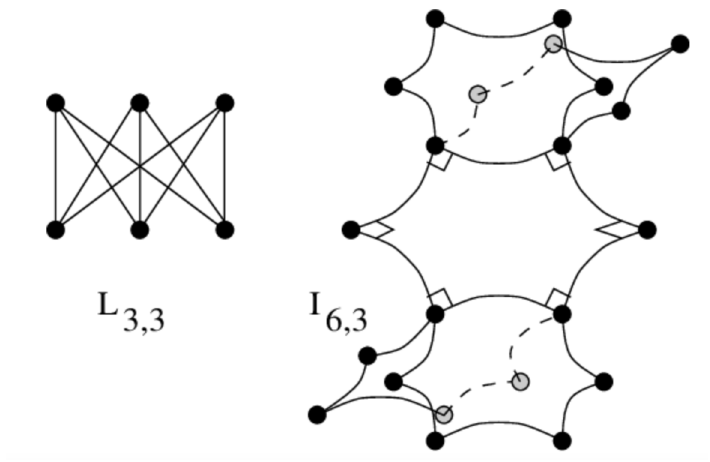
Figure 2 . An example of a subset of a Bourdon building with the associated link, from